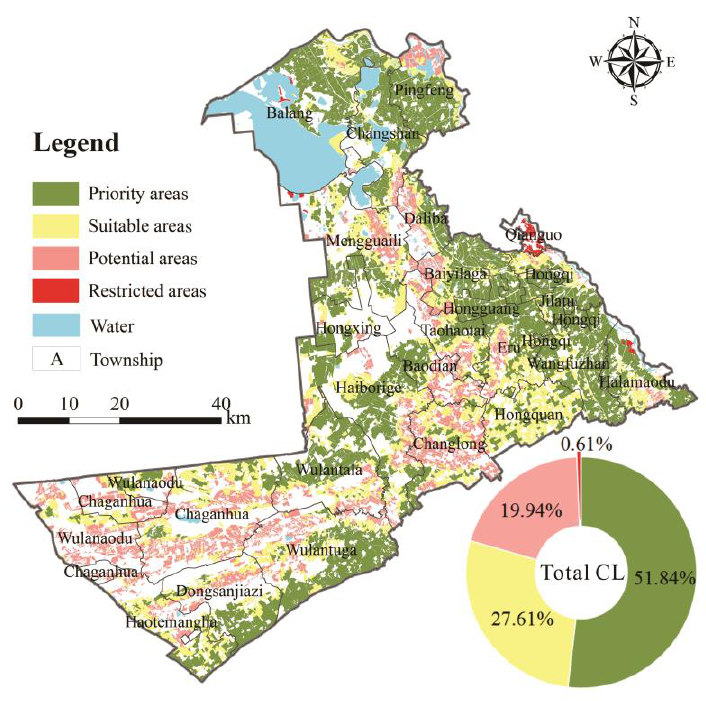
Figure 8. Spatial distribution of the CL delineation potential.